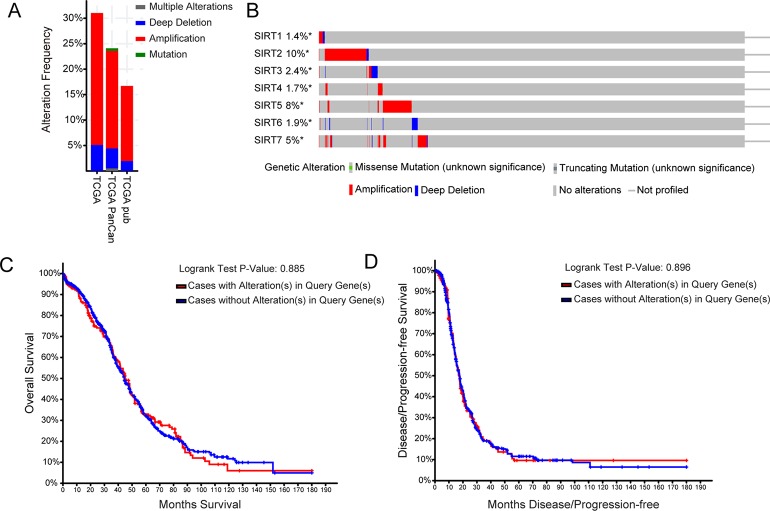
The genetic alteration analysis of SIRTs in patients with OC (cBioPortal). (A) Summary of alteration in SIRTs. (B) OncoPrint tab summary of alteration on a query of SIRTs. Kaplan–Meier plots comparing (C) overall survival (OS) and (D) progression-free survival (PFS) in cases with/without SIRTs gene alterations.